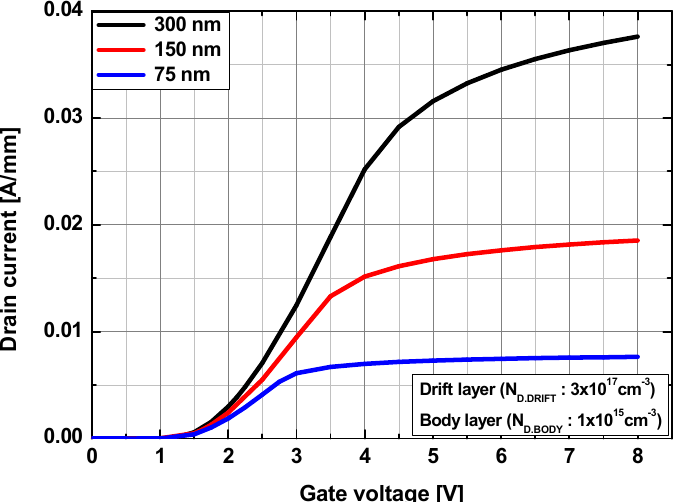
Figure 6. Transfer characteristics at V DS = +5 V as a function of the thickness of the drift channel layer. The drift channel layer has a doping concentration of 3 × 10 17 cm −3 .